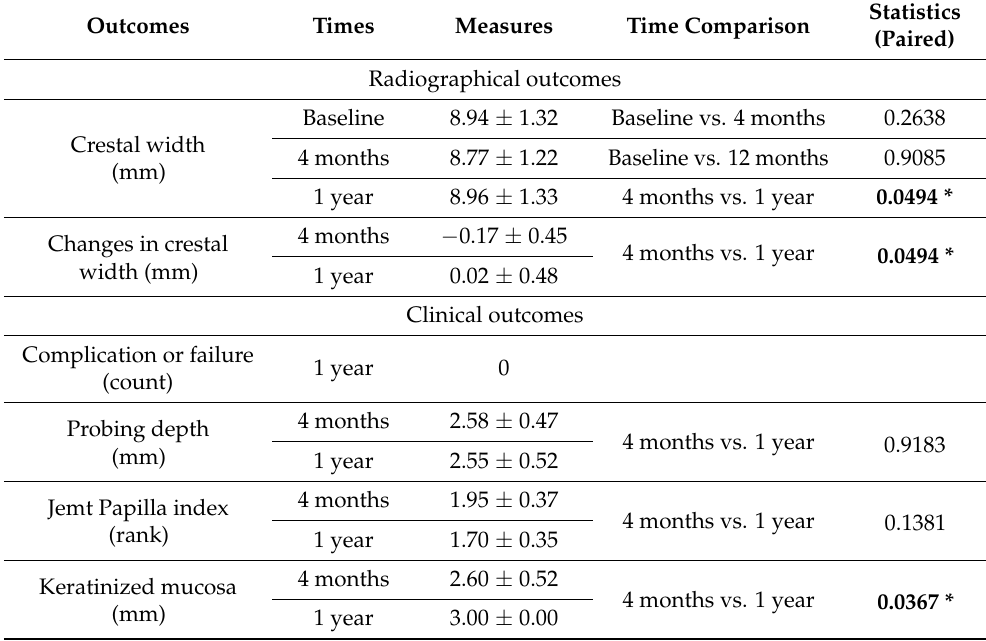
Table 2. Complications and mean clinical and radiographic data during the follow-up period for each case.